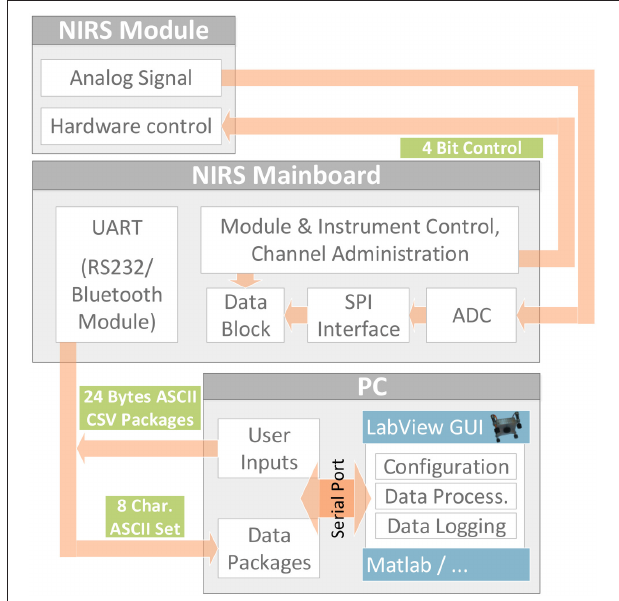
FIGURE 3 | Software and Interface Concept. Stand alone fNIRS module operated via parallel control interface by the mainboard or any custom control and data acquisition device. Function of the 4 Bit interface (3:RST, 2:TRIG, 1:CH1, 0:CH0): Bits CH1:CH0 select one of the four physical NIRS channels. A rising edge on the TRIG line activates the selected channel, always beginning with wavelength 750nm of the corresponding LED. Each subsequent rising edge toggles the activation between 750 and 850nm. When the RST line is pulled up, all channels are turned off. The next rising edge on the TRIG line starts the process again, beginning with